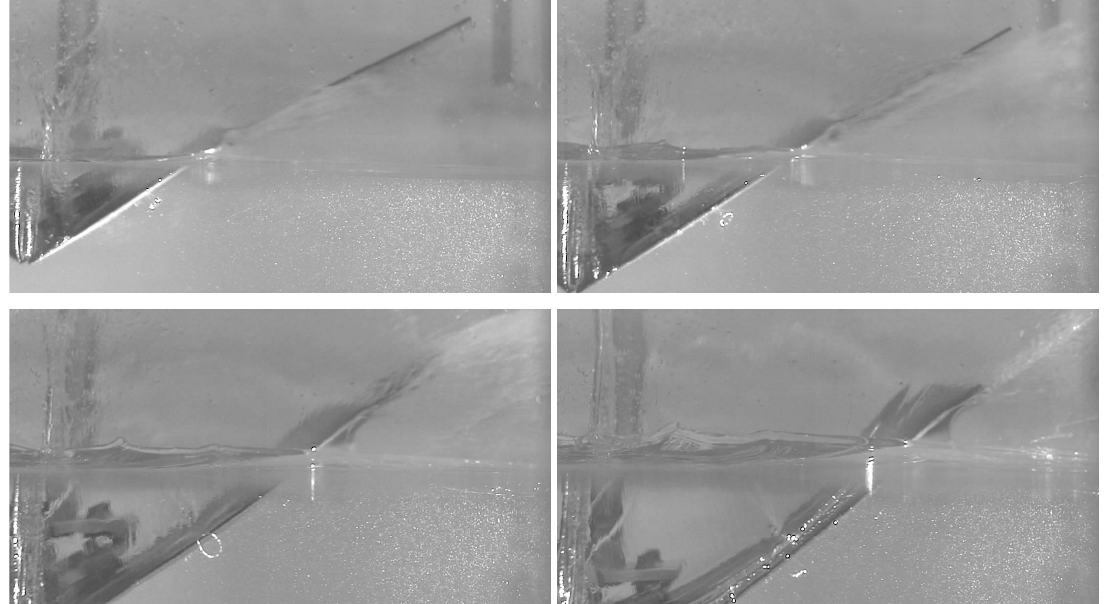
Figure 6. Deformation over time of a fiberglass/vinylester wedge with a deadrise angle of 30 ◦ entering the water at 4.2 m/s. Time advances left to right, top to